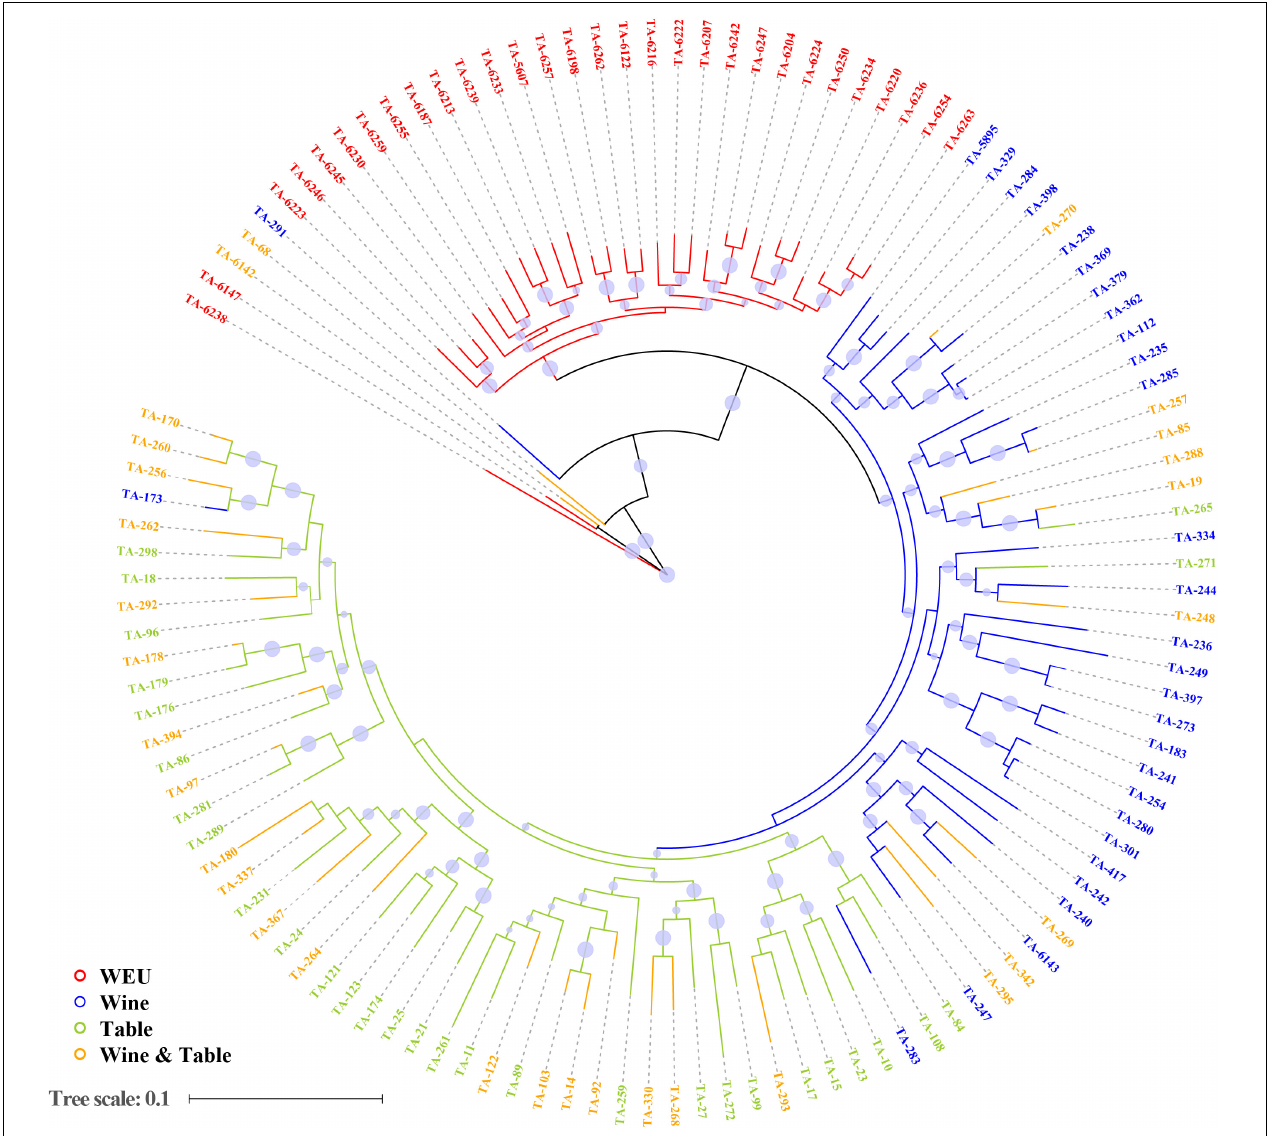
FIGURE 2 | Maximum Likelihood phylogenetic tree of all accessions inferred from whole-genome SNPs. Red, blue, green, and orange represent wild European grapevines (WEU), wine grapes, table grapes and dual-purpose grapevines which can be used for both fresh consuming and wine production, respectively. Bootstrap values are indicated by blue